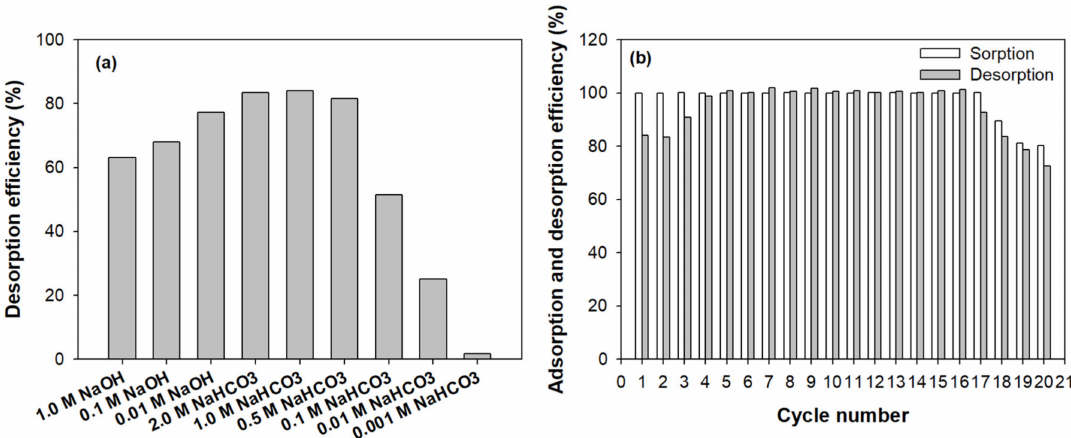
Figure 8. Screening for selecting the best concentration of eluent ( a ) and repeated adsorption–desorption cycles to evaluate the reusability of PEI/PVC-CF for RY2 ( b